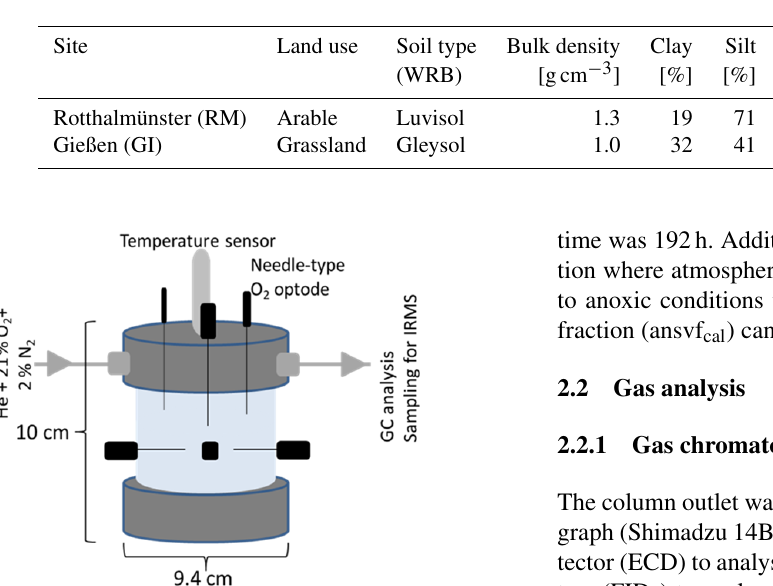
Table 1. Basic description of soil materials used for incubation (SOM: soil organic matter; WRB: World Reference Base for the classification of soil).